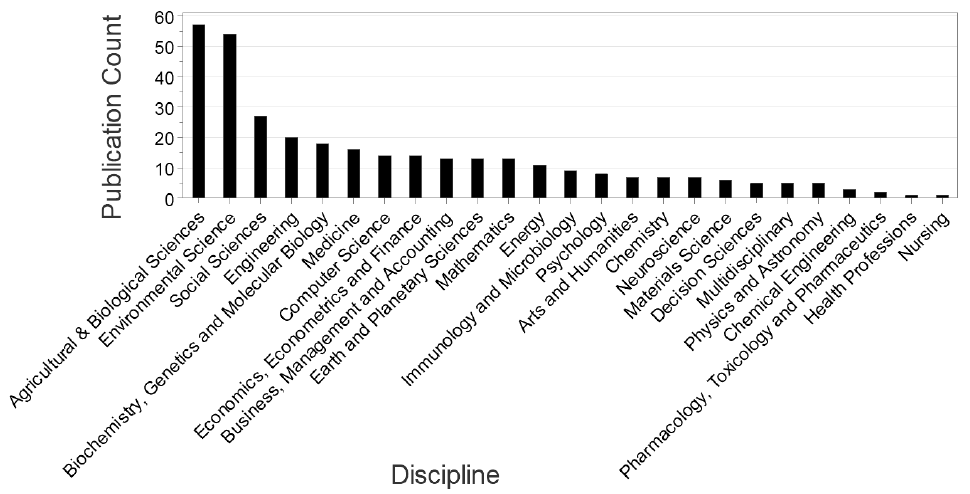
Figure 3. Publication counts listing both stability and resilience in their titles. Data source: [13].